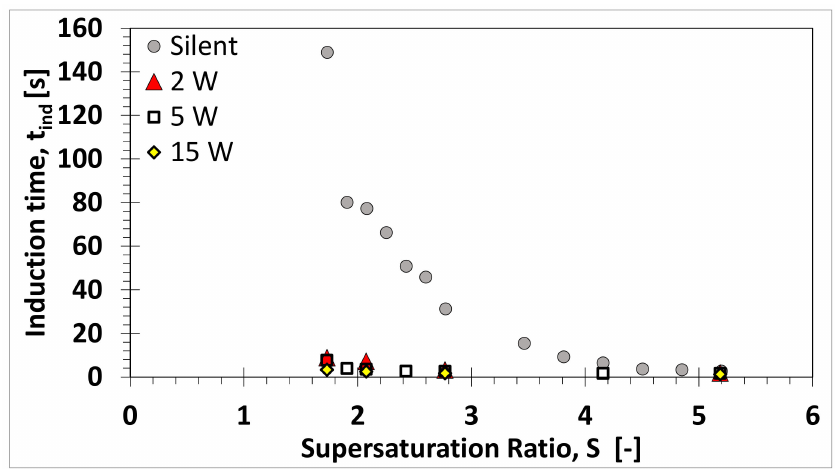
Figure 5. Induction time t ind as a function of supersaturation ratio for silent and presence of ultrasound (98 kHz) at three different power levels.